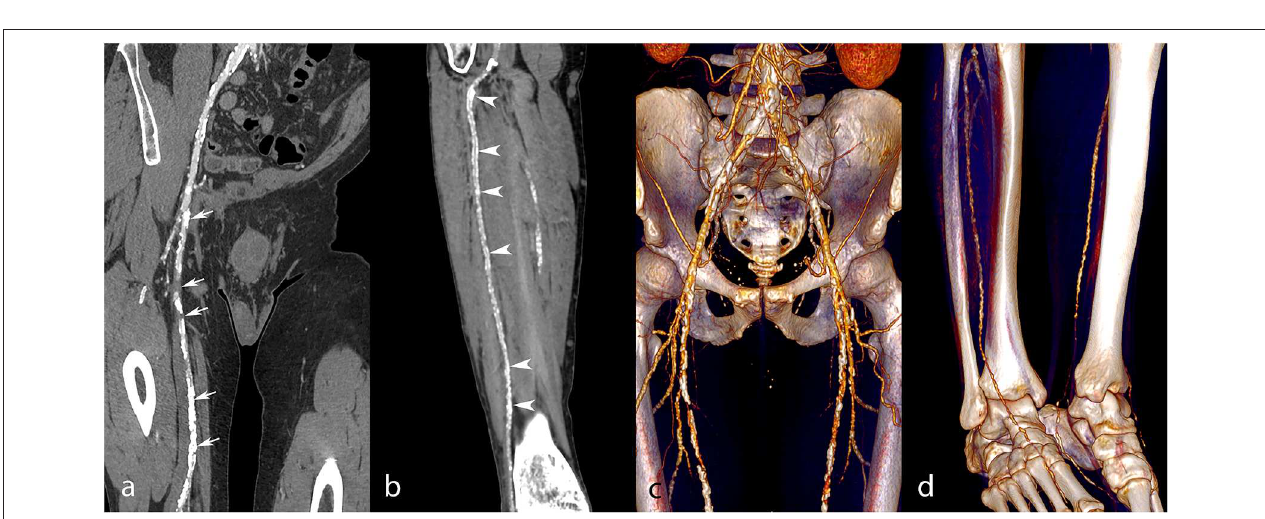
FIGURE 5 | Lower extremity CT angiography obtained with the SA technique in a 54-year-old man with a history of insulin-requiring type 2 diabetes, hypertension, past stroke, and myocardial infarction, who was admitted due to Fontaine stage III peripheral arterial disease. Curvilinear reconstructions (a,b) and corresponding volume rendering reconstructions (c,d) of the right iliofemoral arterial system and anterior tibial artery. Several severe stenoses and occlusions were found along the superficial femoral artery ( a,c , white arrows). At the tibial and pedal levels (b,d) , the arterial enhancement is non-optimal but sufficient for a diagnosis. Nevertheless, note the extensive arterial wall calcifications of the anterior tibial artery (white arrowheads) related to diabetes, rendering the analysis difficult. Attenuation measurements were as follows: aortic level, 261 HU; iliac level, 271 HU (right), and 256 HU (left); femoral level, 191 HU (right), and 176 HU (left); tibial level 187 HU (right), and 172 HU (left); pedal level, 112 HU (right), and 107 (left). HU, Hounsfield